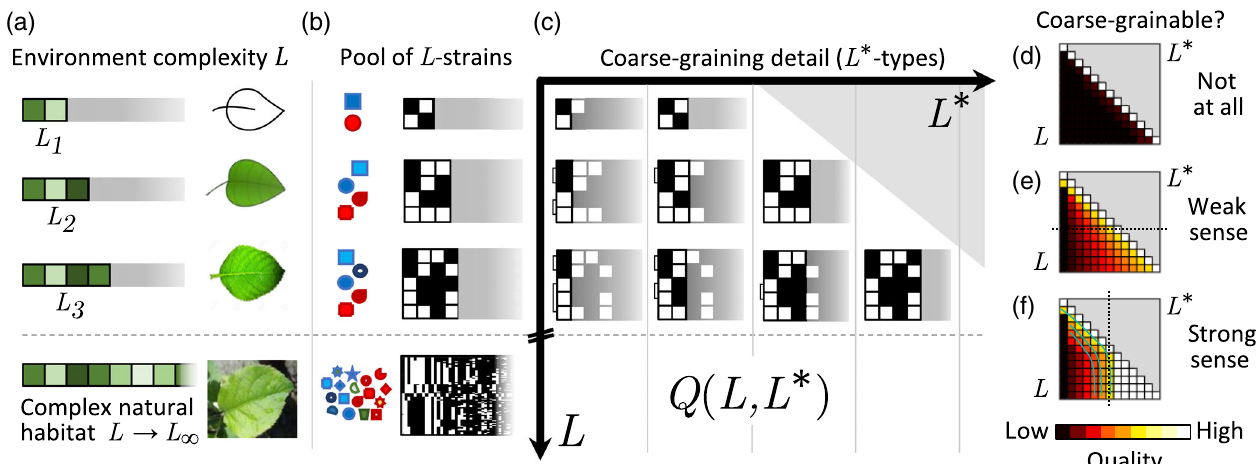
FIG. 3. Defining weak and strong coarse-grainability. (a) The complex natural habitat is modeled as including a large number L ∞ of exploitable resources or opportunities. In a laboratory, we can consider a sequence of ever-more-detailed approximations including resources 1 ; … ; L (with the remaining ones set to zero). (b) For each environment, the model describes the pool of strains we expect to encounter [the pool of “ L -strains ” ; see Fig. 2(f)]. For a given L , the strains are unlikely to carry traits i for resources not provided ( i > L ). As environment complexity L increases, the pool becomes increasingly diverse. (c) The set of L -strains can be coarse-grained to a varying level of detail L (cid:3) ≤ L . Let Q ð L; L (cid:3) Þ be any quantitative metric (to be defined later) scoring the quality of the L (cid:3) -coarse- graining in the environment of complexity L . At L (cid:3) ¼ L , the strain diversity is fully resolved (no coarse-graining). The “ coarse- grainability ” of the ecosystem is encoded in the behavior of Q ð L; L (cid:3) Þ at L (cid:3) < L . Different metrics Q encode different operational definitions of coarse-grainability. (d) A non-coarse-grainable ecosystem ( sensu quality metric Q ). The coarse-graining quality remains poor unless the microscopic strain diversity is fully resolved (at L (cid:3) ¼ L ). (e) Weak-sense coarse-grainability: In any given environment (a fixed L , highlighted), a desired quality can be achieved with a coarser-than-microscopic description ( L (cid:3) < L ). (f) Strong-sense coarse-grainability: The same coarse-graining (a fixed L (cid:3) , highlighted) provides the desired quality even as the environment complexity is